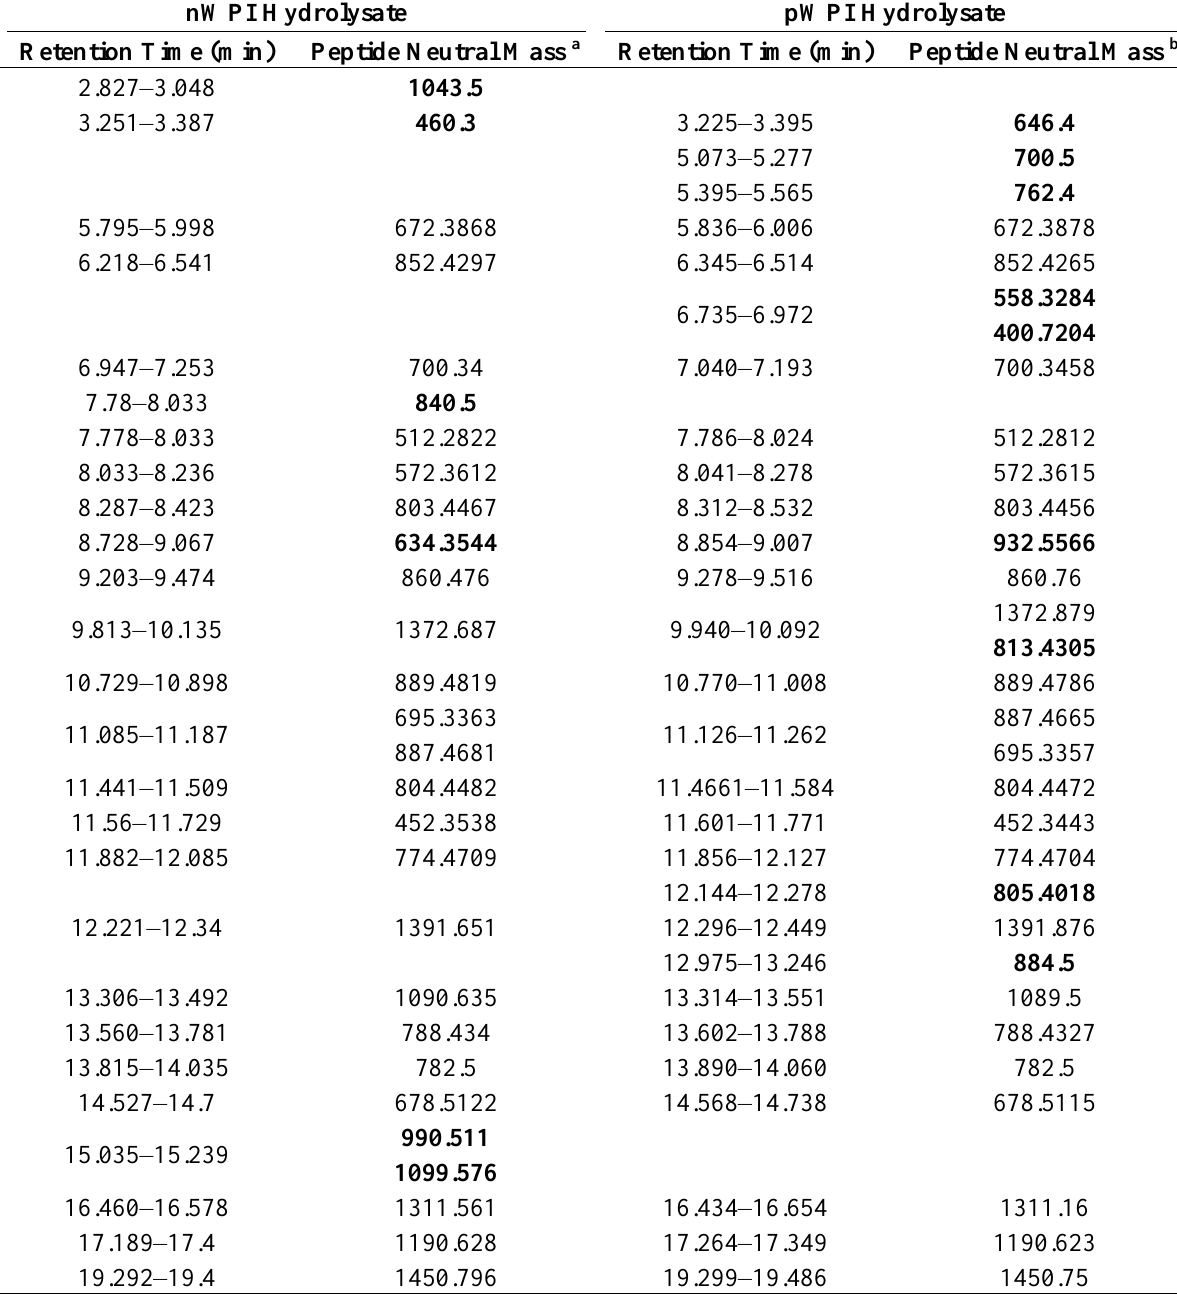
Table 1. Neutral mass of peptides as assessed by